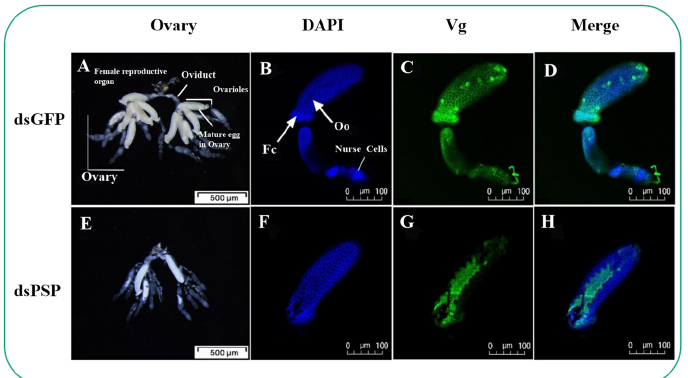
Figure 8. Effect of dsPSP treatments on the female reproductive system in C. lividipennis at 7 DAE. Compared to controls, reproductive tracts isolated from dsPSP-treated female adults showed limited ovarian development ( A , E ) with a scale bar = 500 μ m. Similar dsPSP treatments reduced ovar- ian Vg accumulation at 7 DAE ( C , G ), recorded with fluorescence staining. ( B , F ) Compared to con- trols, reduced nuclear staining in experimental preparations and ( D , H ) depicts the merged micro- photographs scale bar = 100 μ m. DAE is days after emergence; DAPI is 4 ′ ,6-diamidino-2- phenylindole.